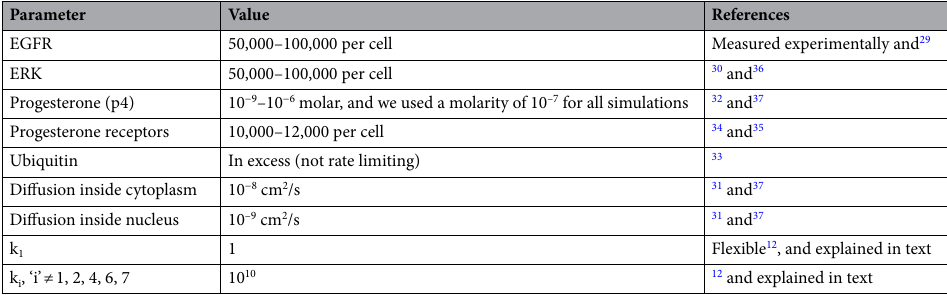
Table 1. Concentrations of molecular species, diffusion, and reaction rates.